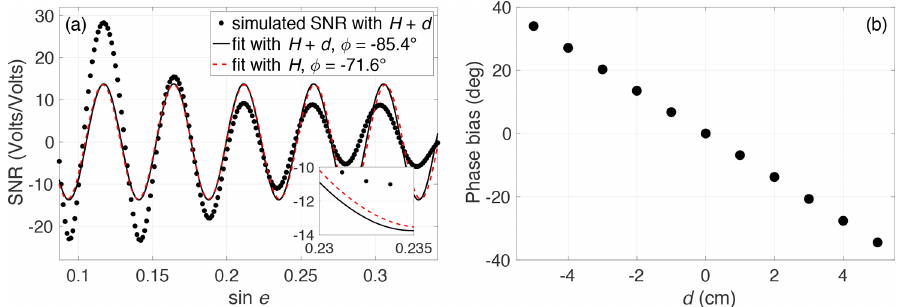
Figure 3. (a) Simulated SNR with H + d and their fits based on H + d and H , respectively. In this simulation, H and d are fixed as 2m and 2cm, respectively. The inset plot shows that the phases of these two fits are different. (b) The simulated phase bias when using various d